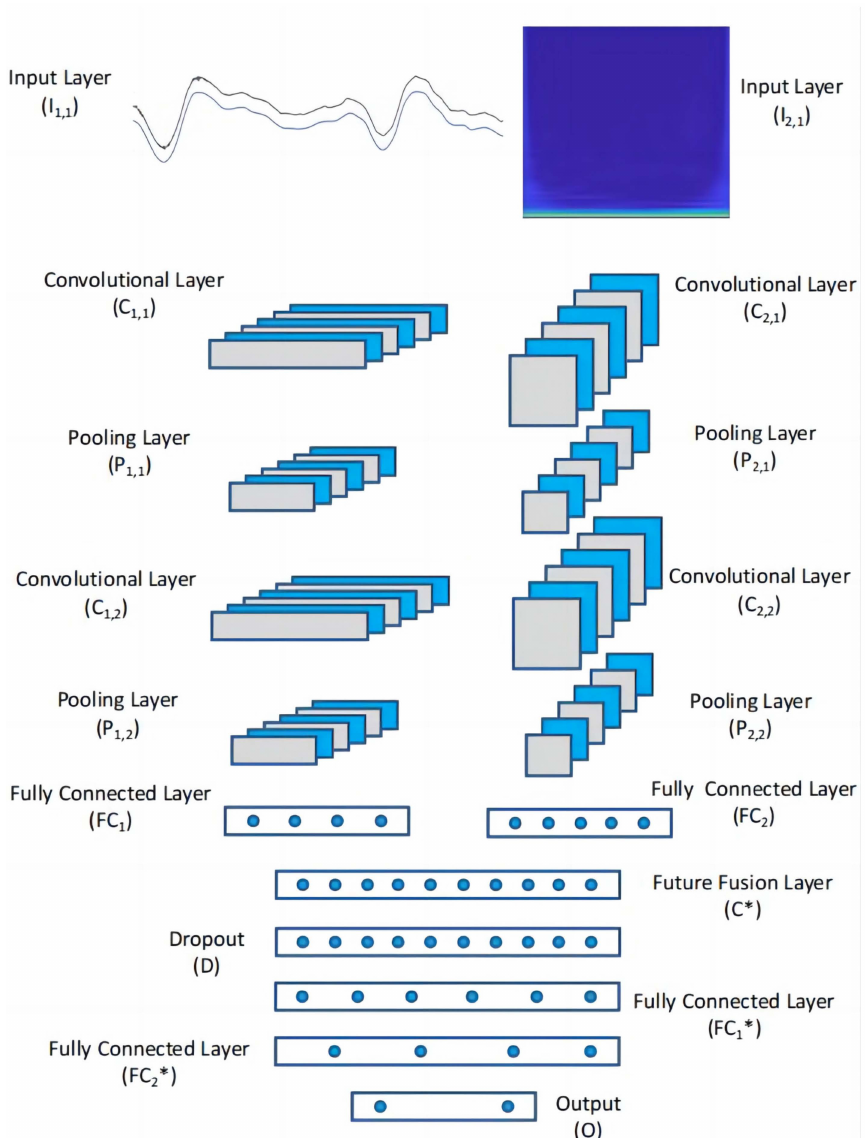
Figure 10. Structure of TC-CNN classifier. Referring to other TC-CNN models, * is to distinguish layers with the same name that have appeared